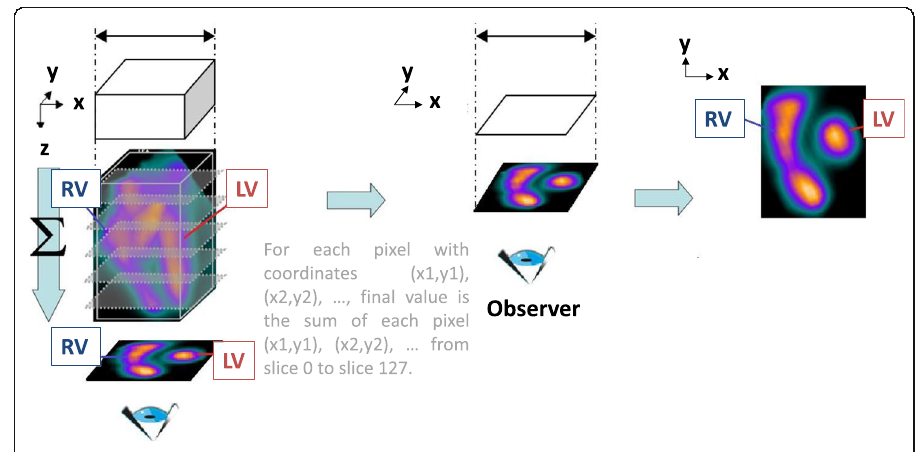
Fig. 2 Schematic depiction of the automated Python method for producing “ pseudo-planar ” PET images. The “ pseudo-planar ” image was obtained by summing the signals in all 127 PET slices along the z -axis. Preorientation allowed the z -axis to be aligned with the cardiac small axis. LV, left ventricle; RV, right ventricle